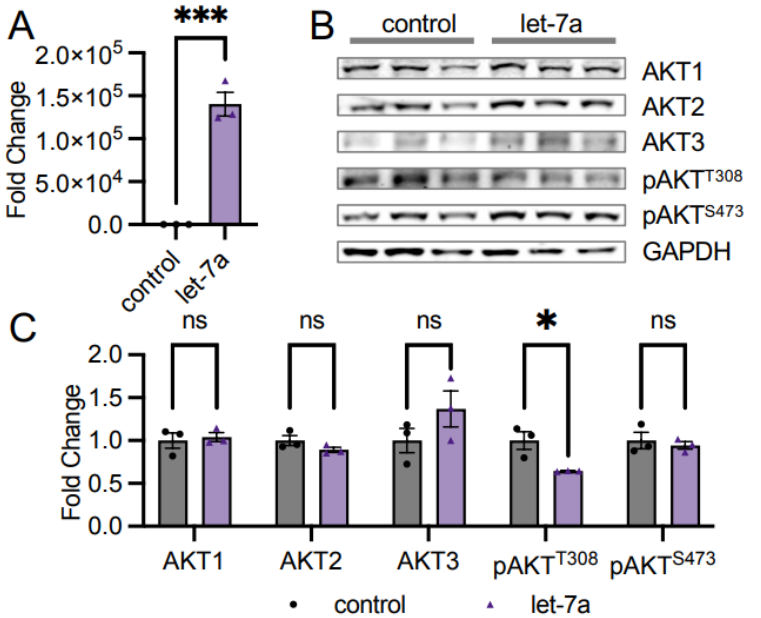
Figure 3. AKT phosphorylation is downregulated in let-7a transfected cells. ( A ) RT-qPCR of let-7a miRNA levels in unstimulated HEK 293T cells transfected with 60 fmol let-7a (purple triangles) or a control transfection lacking RNA (black circles). ( B ) Western blots of AKT isoforms and pAKT protein levels were ( C ) quantified in cells treated as in ( A ). The data include n = 3 biological replicates. Error bars show ± 1 SEM. Asterisks indicate significance (ns, not significant; * p < 0.05; *** p <